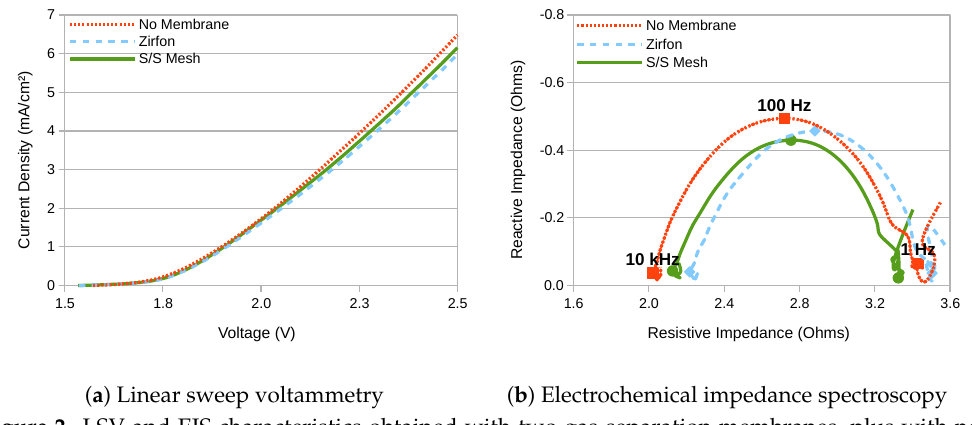
Figure 2. LSV and EIS characteristics obtained with two gas-separation membranes, plus with no membrane for comparison. Table 1. Series electrical resistance between the electrodes derived from the EIS results presented in Figure 2b. The membrane area resistance R M is derived from the value of ∆ R S . The woven stainless-steel membrane therefore exhibited just over half the electrical resistance of